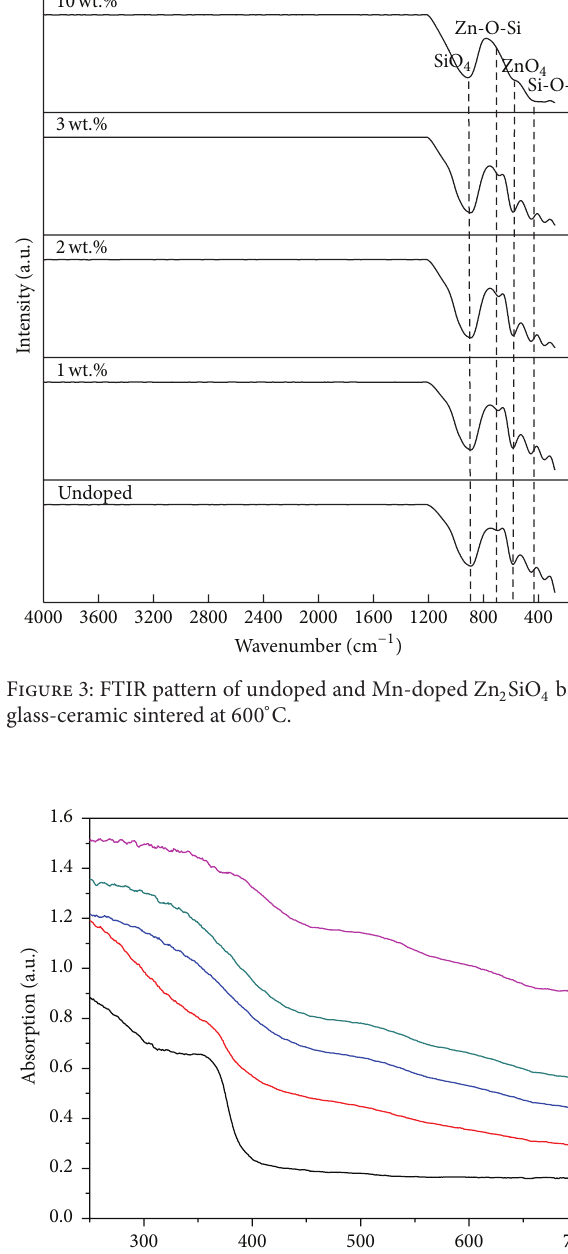
Table 3: FTIR spectral bands assigned to the vibrational modes.